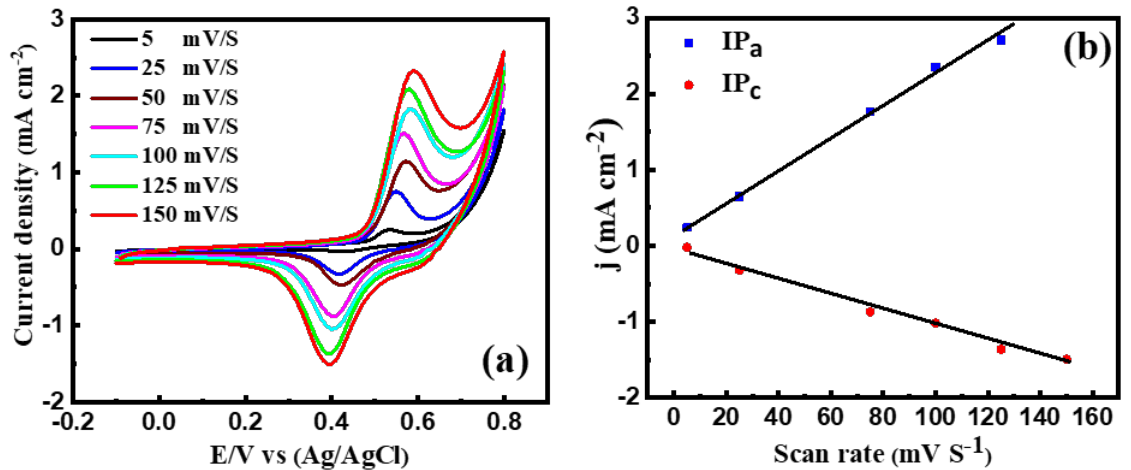
Figure 5. ( a ) Cyclic voltammograms (CVs) of CuNi-MC at different scan rates and ( b ) peak current density as a function of scan rates at pH 12.